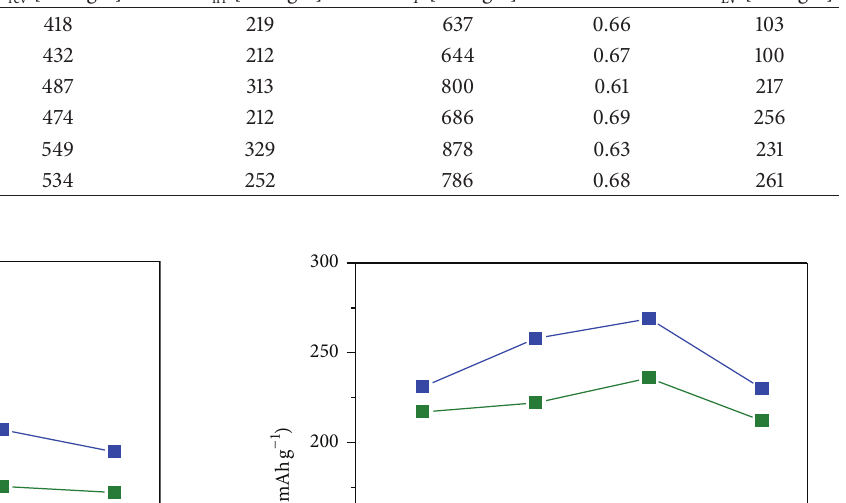
Table 3: Porosity parameters and reversible and irreversible capacity values for the first cycle discharge charge. Sample